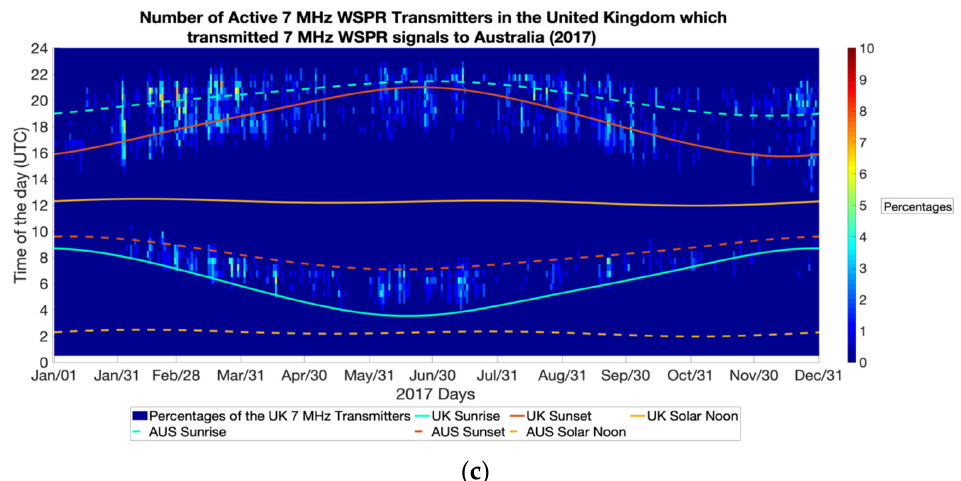
Figure 15. ( a ) The 7 MHz radio links made from the UK to Australia in 2017. The blue shaded area is the Australian daytime hours. The red area is the UK daytime hours. The yellow shaded area is the common daytime hours, and the white shaded area is the common night hours. The colours indicate the number of links available in each half-hour interval. ( b ) Percentages of active Australian WSPR receivers which have received a link from the UK in 2017. Only receivers with a proven capability to cover the distance from the UK to Australia are shown. The colours indicate the number of receivers available in each half-hour interval. ( c ) Percentages of active UK WSPR transmitters which have transmitted a link to Australia in 2017. Only transmitters with a proven capability to cover the distance from the UK to Australia are shown. The colours indicate the number of receivers available in each half-hour interval.